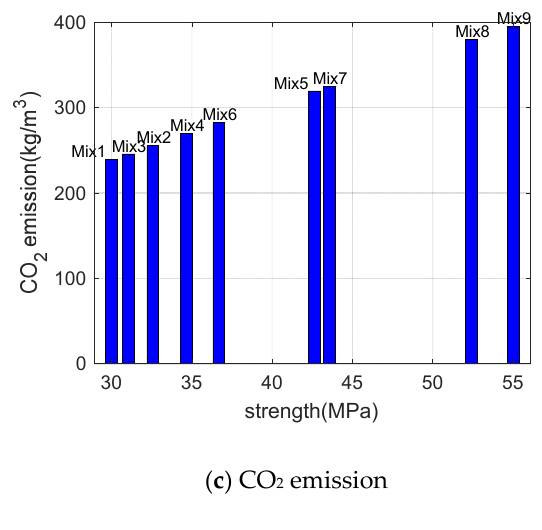
Figure 5. Overall tendency of optimization mixtures.